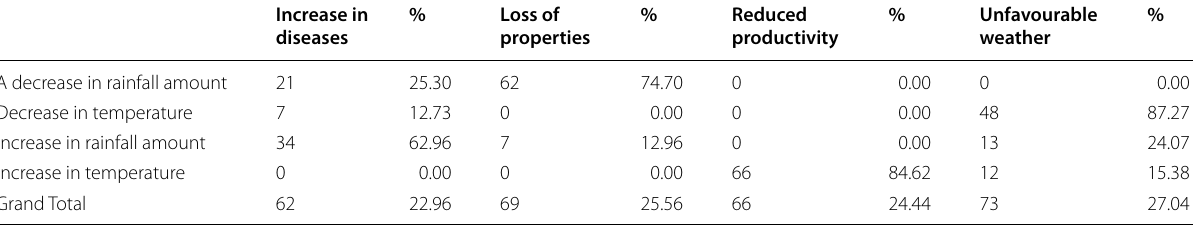
Table 7 Cross-tabulation analysis showing perception of climate change versus challenges to livelihood